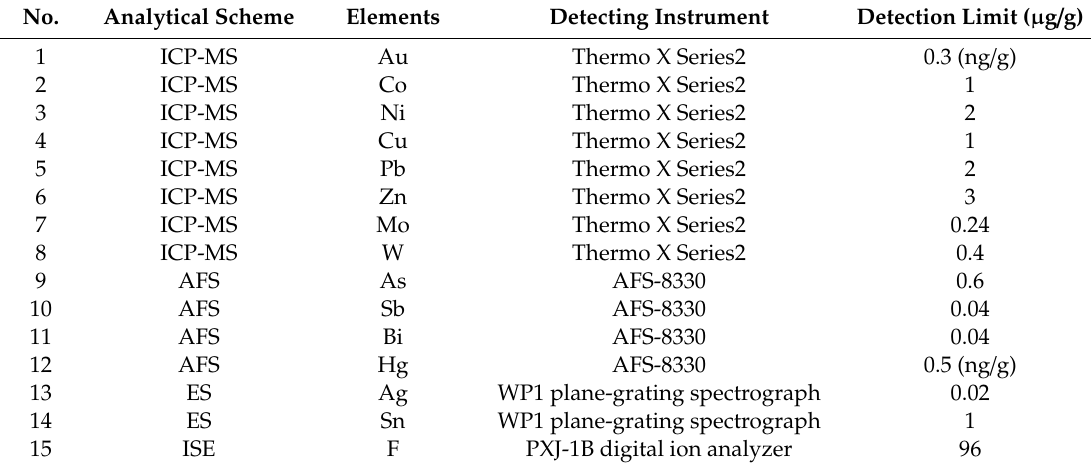
Figure 5. Simplified geological map of the Laowan gold deposit with sampling locations (the size of the sample point represents the concentration of Au). Table 1. Analytical schemes and detection limits for 15 elements.